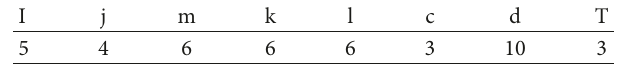
Table 2: Dimensions of the problem.